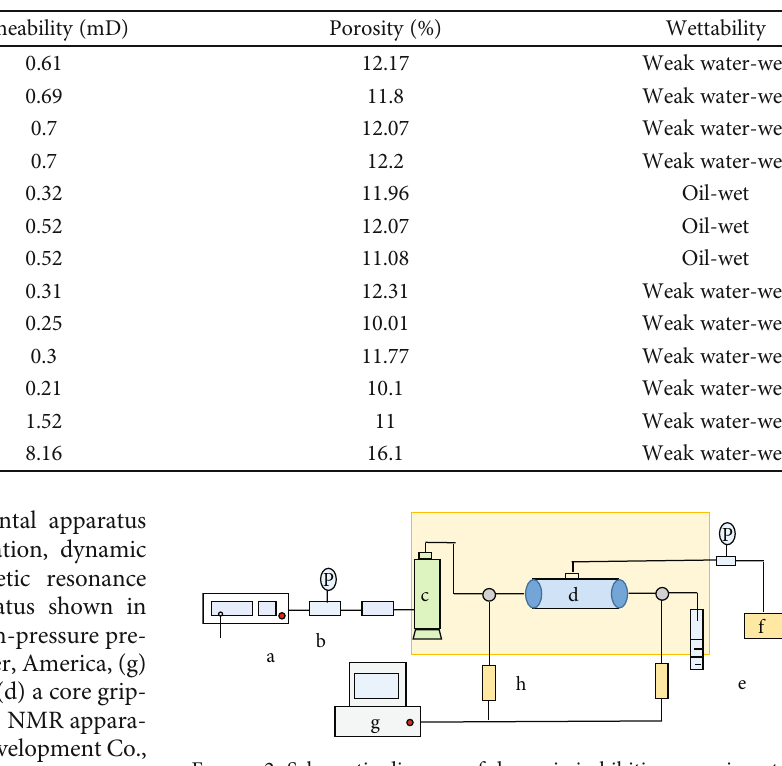
Figure 2: Schematic diagram of dynamic imbibition experimental